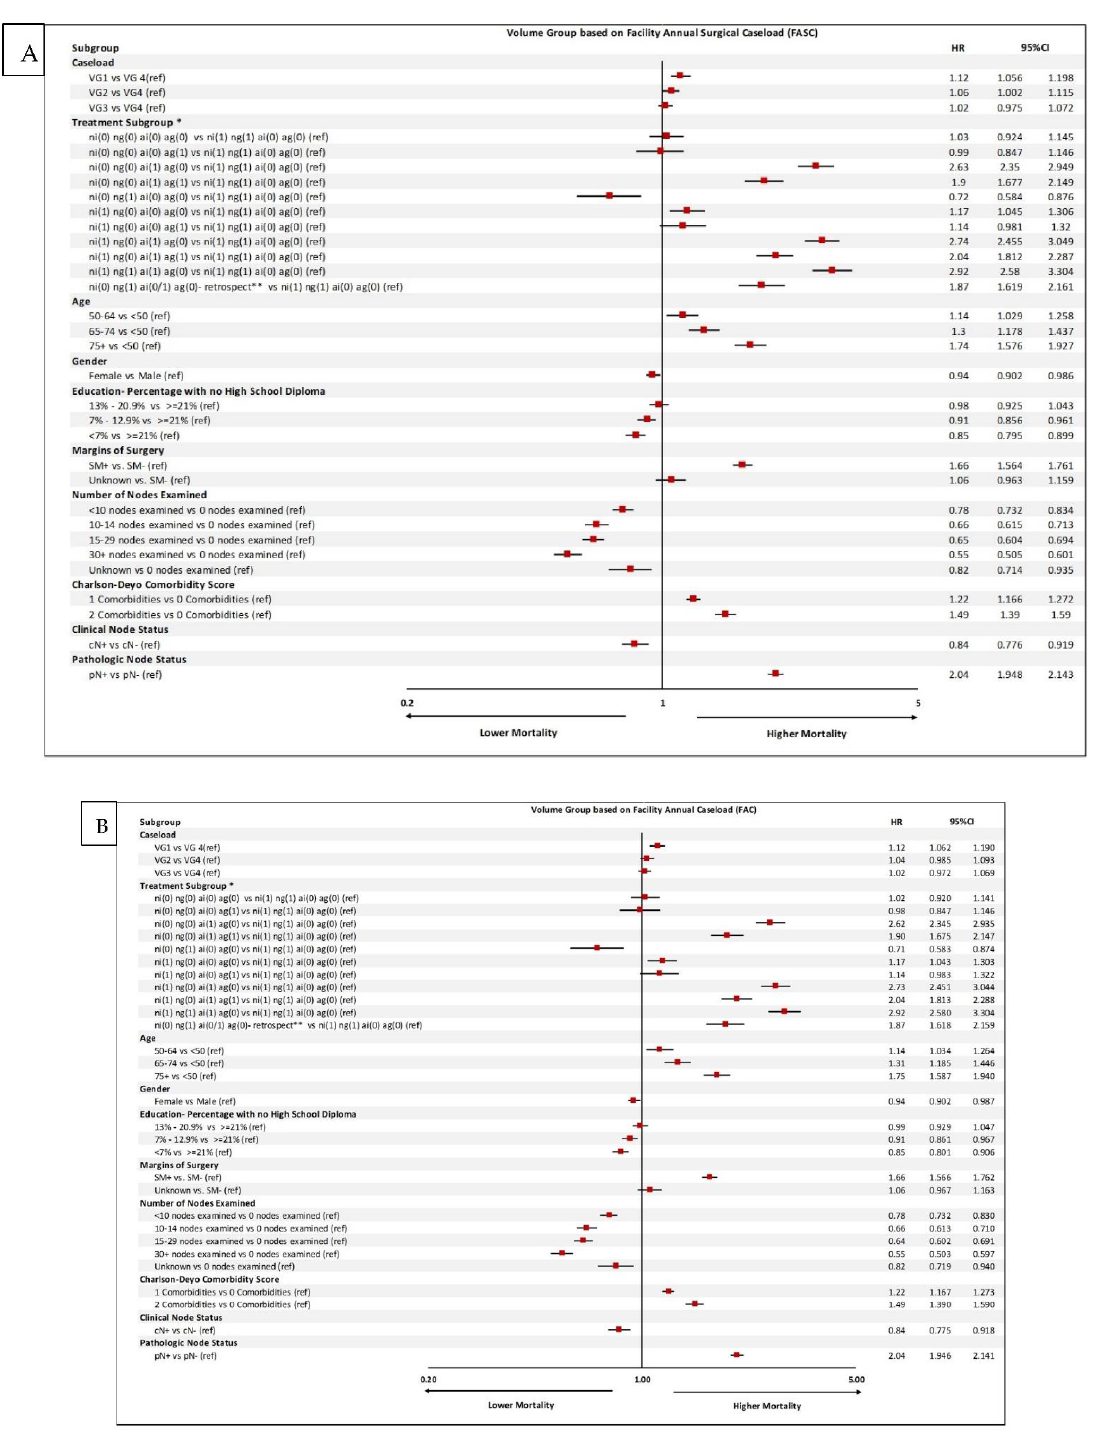
Figure 2. Multivariable logistic regression analysis of predictors of mortality based on ( A ) facility annual surgical caseload (FASC) and ( B ) facility annual caseload (FAC). HR: hazard ratio; SM: surgical margin; VG: volume group; * refers to the combination of the following: NI: neoadjuvant chemo indicated; NG: neoadjuvant chemo given; AI: adjuvant chemo indicated; AG: adjuvant chemo